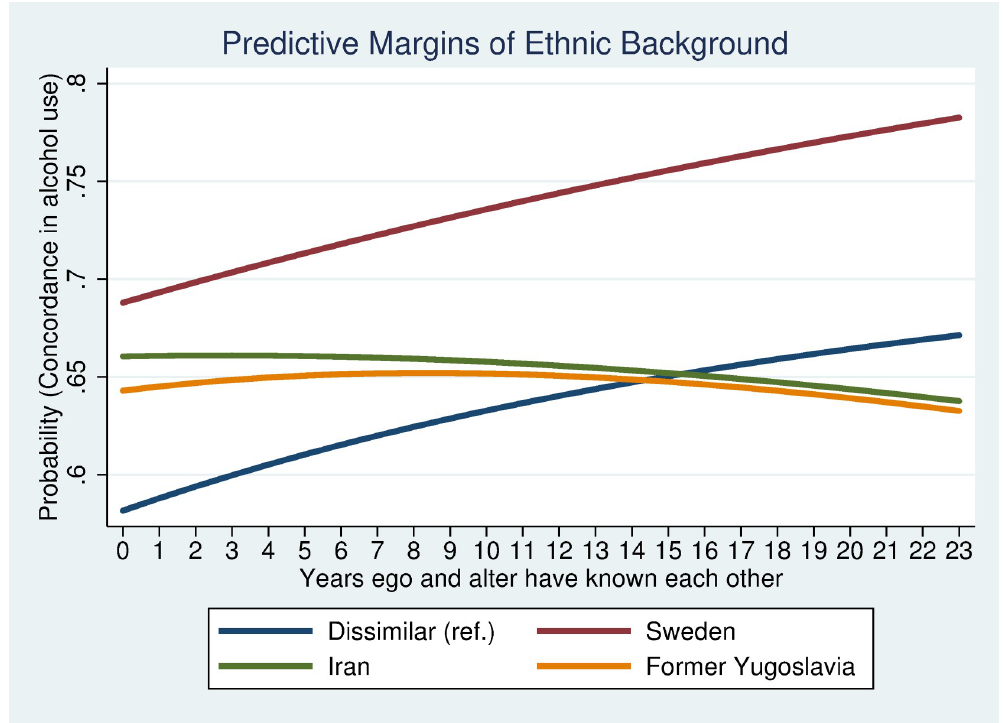
Fig 3. Concordance in alcohol habits by friendship duration.